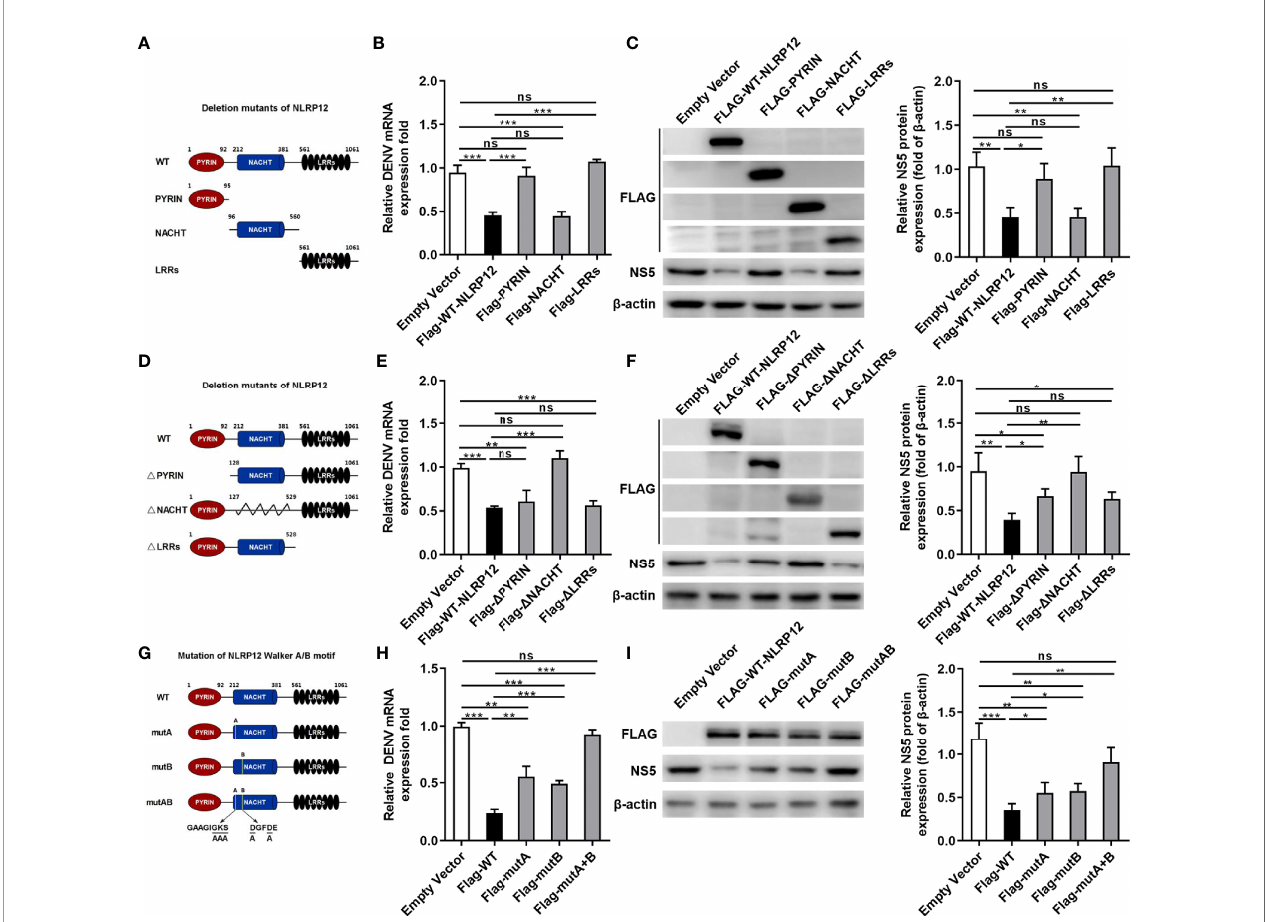
FIGURE 4 | NACHT domain was critical for the functions of NLRP12 in suppressing viral replication. (A) Expression plasmids for Flag-tagged NLRP12 truncation mutants were constructed according to the structure of PYRIN domain, NACHT domain and LRRs domain. (B, C) The plasmids carrying the Flag-tagged truncations were transformed into dTHP-1 cells, after which the cells were infected with DENV at a MOI of 4 for 72h, qPCR and western blot were performed to determine the levels of genome RNA and the nonstructural proteins NS5.The protein bands were analyzed by Image J gel image analysis software and normalized to b -actin. (D) Expression plasmids of NLRP12 lacking the PYRIN domain, the NACHT domain or the LRRs domain were constructed accurately. (E, F) Plasmids with deletions were transfected into dTHP-1 cells, after which the cells were infected with or without DENV at a MOI of 4 for 72h and assessed for the levels of genome RNA and the nonstructural protein NS5. The protein bands were analyzed by Image J gel image analysis software and normalized to b -actin. (G, H, I) FLAG-tagged NLRP12 with Walker A/B mutations (mutA, mutB and mutA+B) were generated, and each of them was overexpressed into dTHP-1 cells. Following by DENV infection for 72h at a MOI of 4. Cell extracts were collected and the intracellular viral RNA levels, as well as the protein levels of NS5 were determined. NS5 protein bands were analyzed by Image J gel image analysis software and normalized to b -actin. Each experiment was repeated a minimum of three times and the statistical signi fi cance was determined with analysis of one-way analysis of variance (ANOVA). ns, non signi fi cant, *P < 0.05, **P < 0.01, ***P <